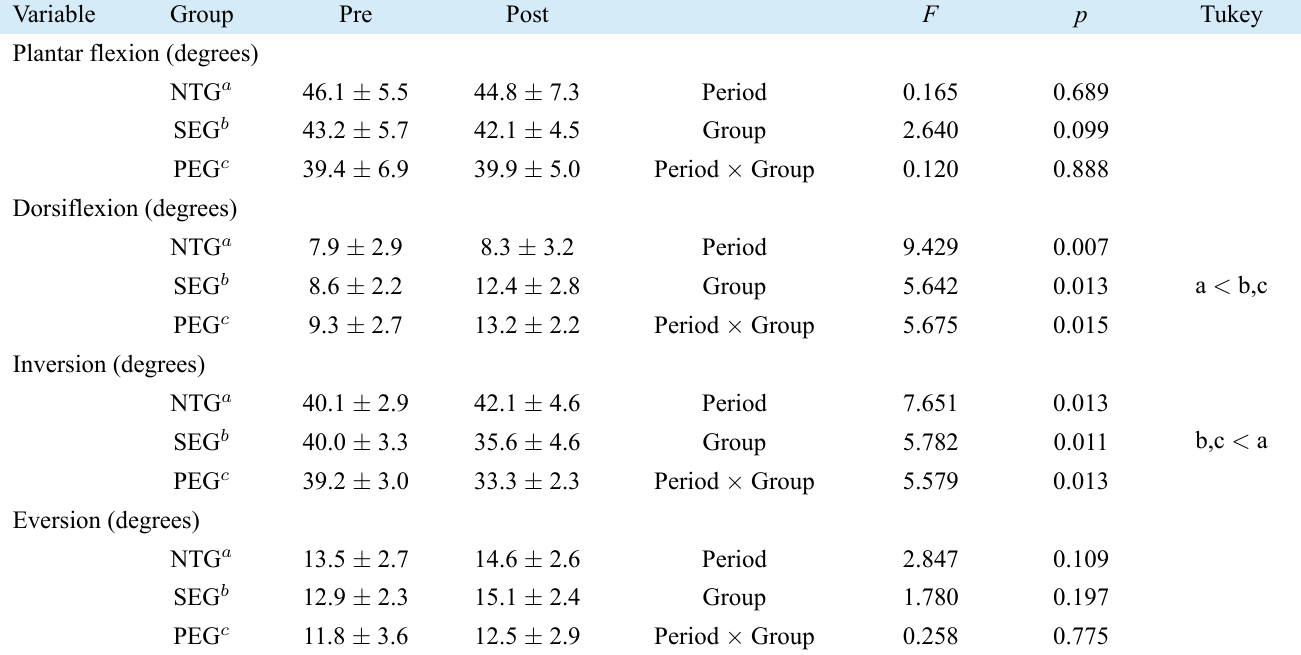
TABLE 4. Changes in active ROM of the ankle.